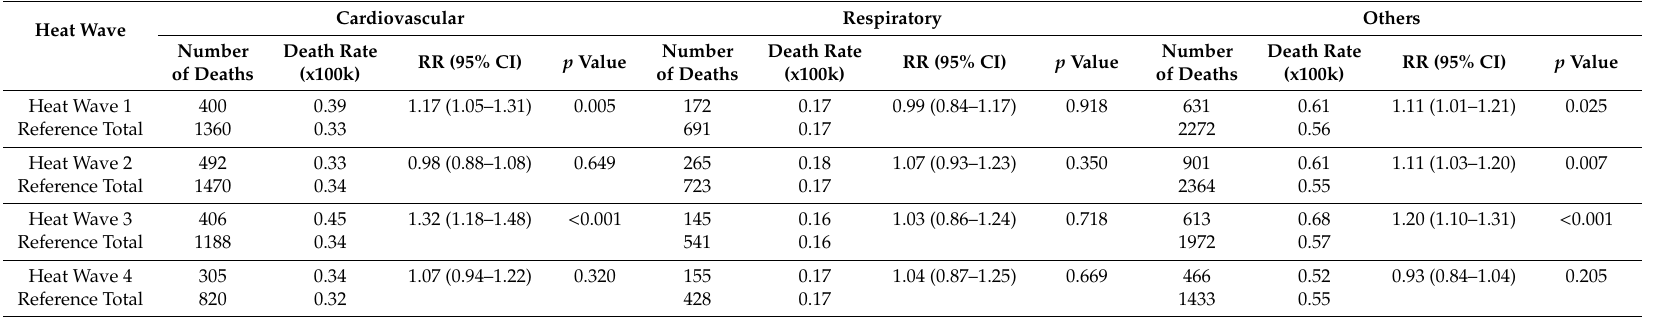
Table 5. Cause-specific Death Rates and Risk Ratios of the Extreme Heat Waves between 2013 and